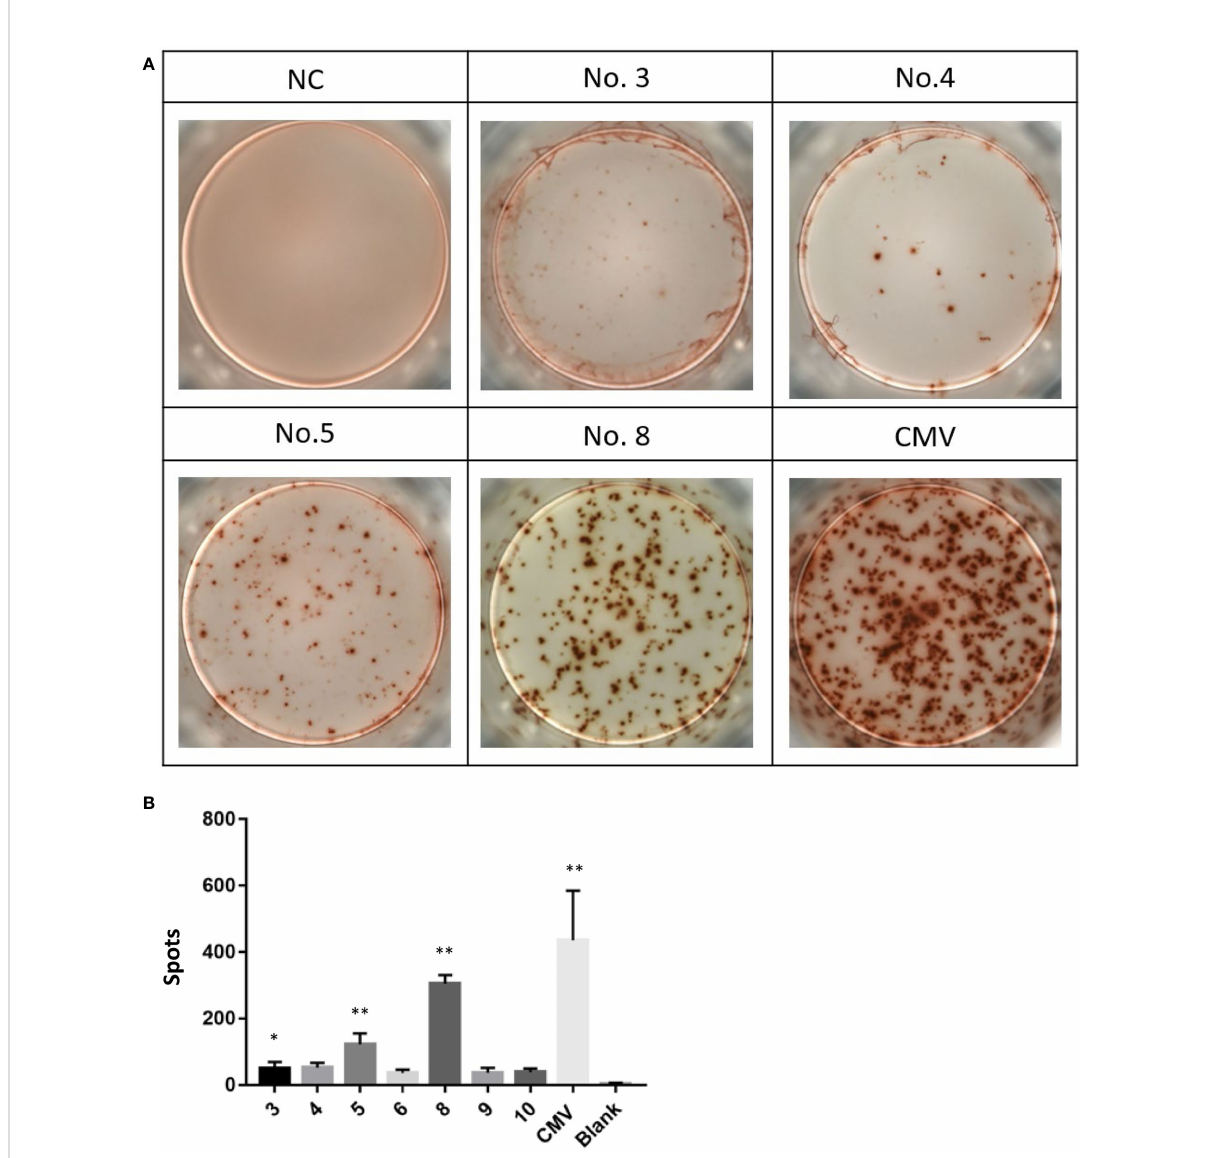
FIGURE 3 Peptides No. 5 and No. 8 of AKAP4 protein can induce T cells to secrete IFN- g in vitro. (A) Images of the ELISPOT assay. NC: Negative control, No. 3, 4, 5, and 8: Peptide No. 3, Peptide No. 4, Peptide No. 5, and Peptide No. 8; CMV: CMV peptide (positive control). (B) The score of Peptide No. 5 and Peptide No. 8 was higher than NC in ELISPOT assay (summarized the results of three independent experiments). Kruskal – Wallis rank sum was performed to assess the signi fi cance in (B) * p < 0.05, ** p <